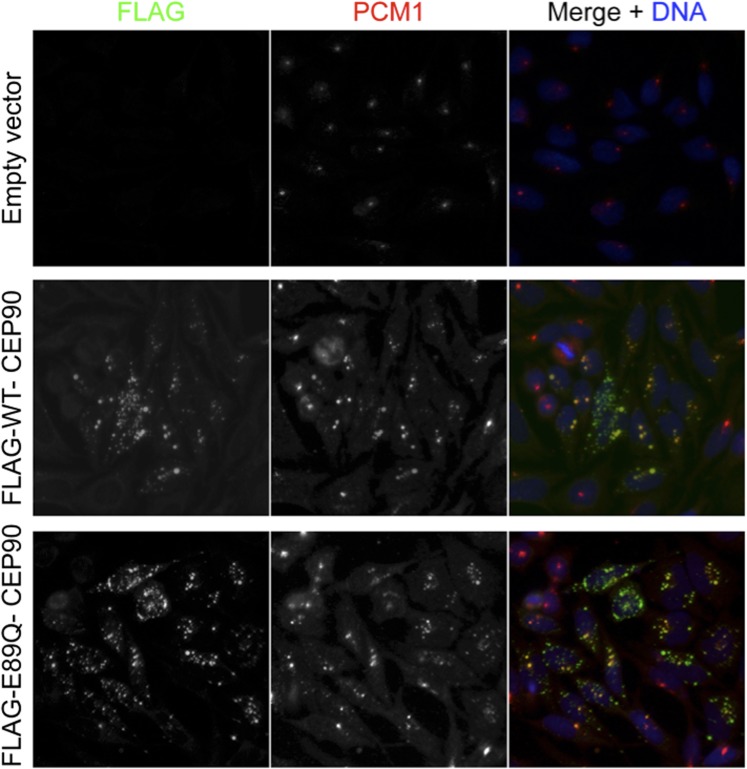
DOI:
http://dx.doi.org/10.7554/eLife.07519.039